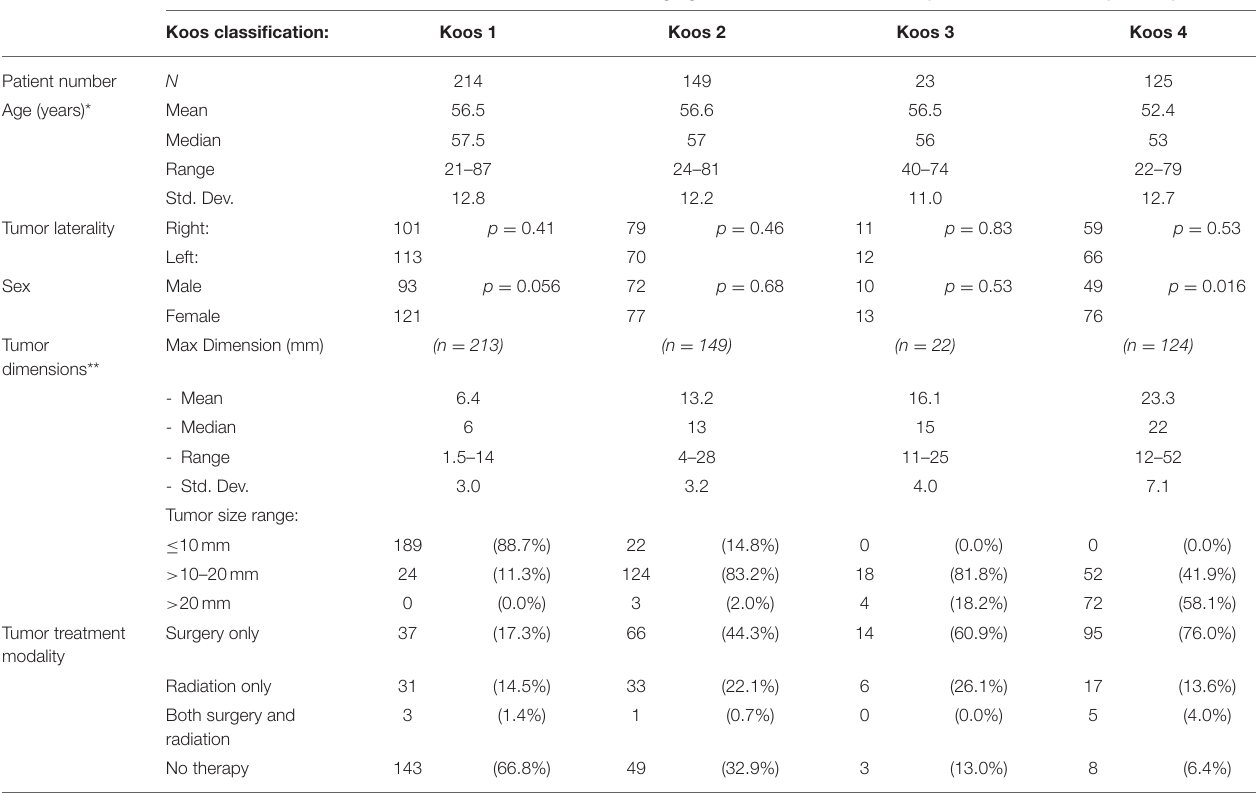
TABLE 2 | Tumor dimensions in patients with sporadic unilateral